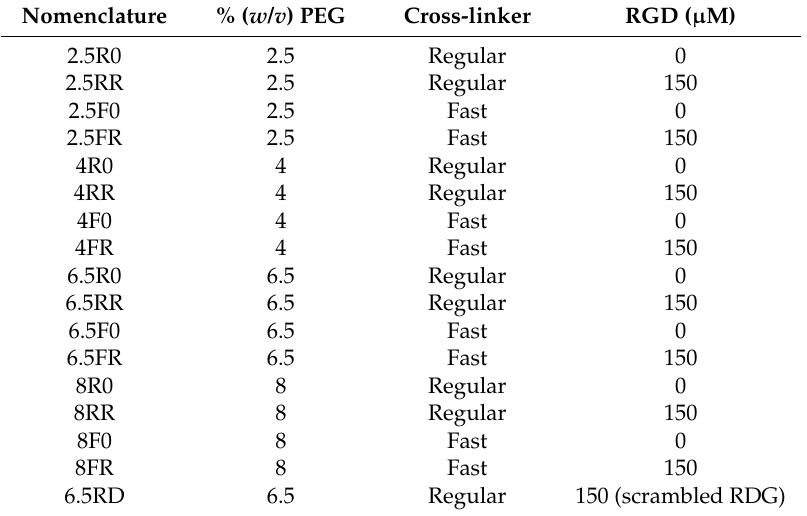
Table 1. Hydrogel nomenclature based on respective